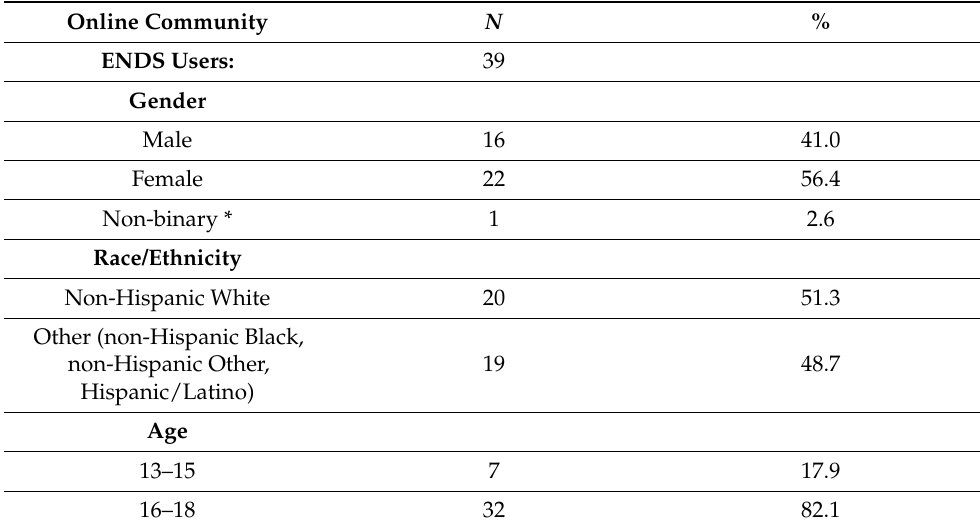
Table 7. Participant Characteristics—Qualitative